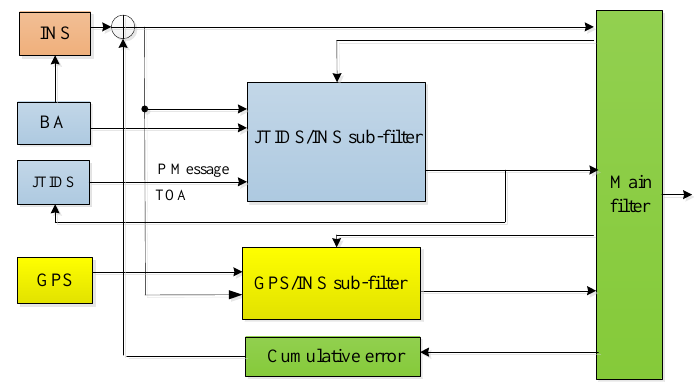
Figure 7. Filter structure of navigation sources.